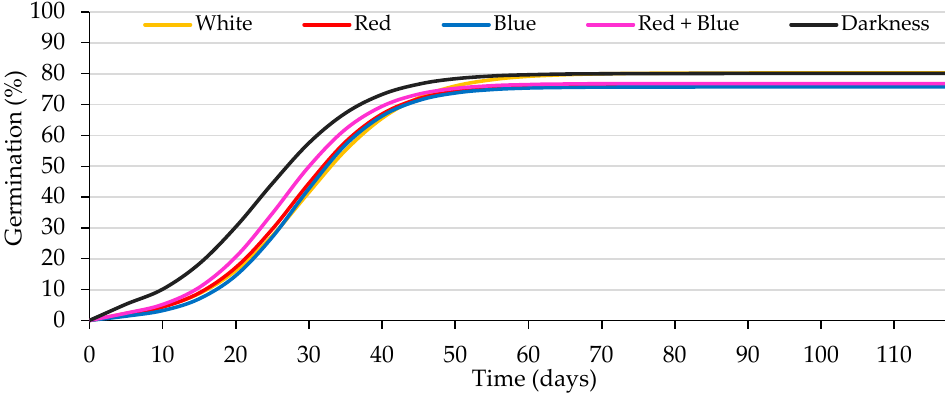
Figure 2. Logistic model adjusted to the curves of accumulated germination of caper seeds from Experiment 2. Average values for the seed exposure to white, red, blue or red + blue lights and to darkness. A 500 mg L − 1 GA 3 solution was used to wet the substrate. No significant differences were obtained between the A values obtained in white light (80.3%) and in darkness (80.1%), indicating that the caper seeds germinated equally in white light and darkness, which was corroborated by the values of the Photoblastic Index (PI = − 0.001) and Relative Light Germination (RLG = 0.5). These results confirmed those obtained in the previous experiment, that caper seeds are insensitive to white light; thus, nurseries could save the energy needed to illuminate the seeds during germination. Caper seeds were also insensitive to blue light, even though all plants had cryptochromes [16], photoreceptors of blue light (400–500 nm; [13]). They were also insensitive to red light, even though phytochromes are photoreceptors of red light (600– 700 nm). Neither Marín [54], nor Moreno et al. [55], obtained significant differences ( p ≤ 0.05)